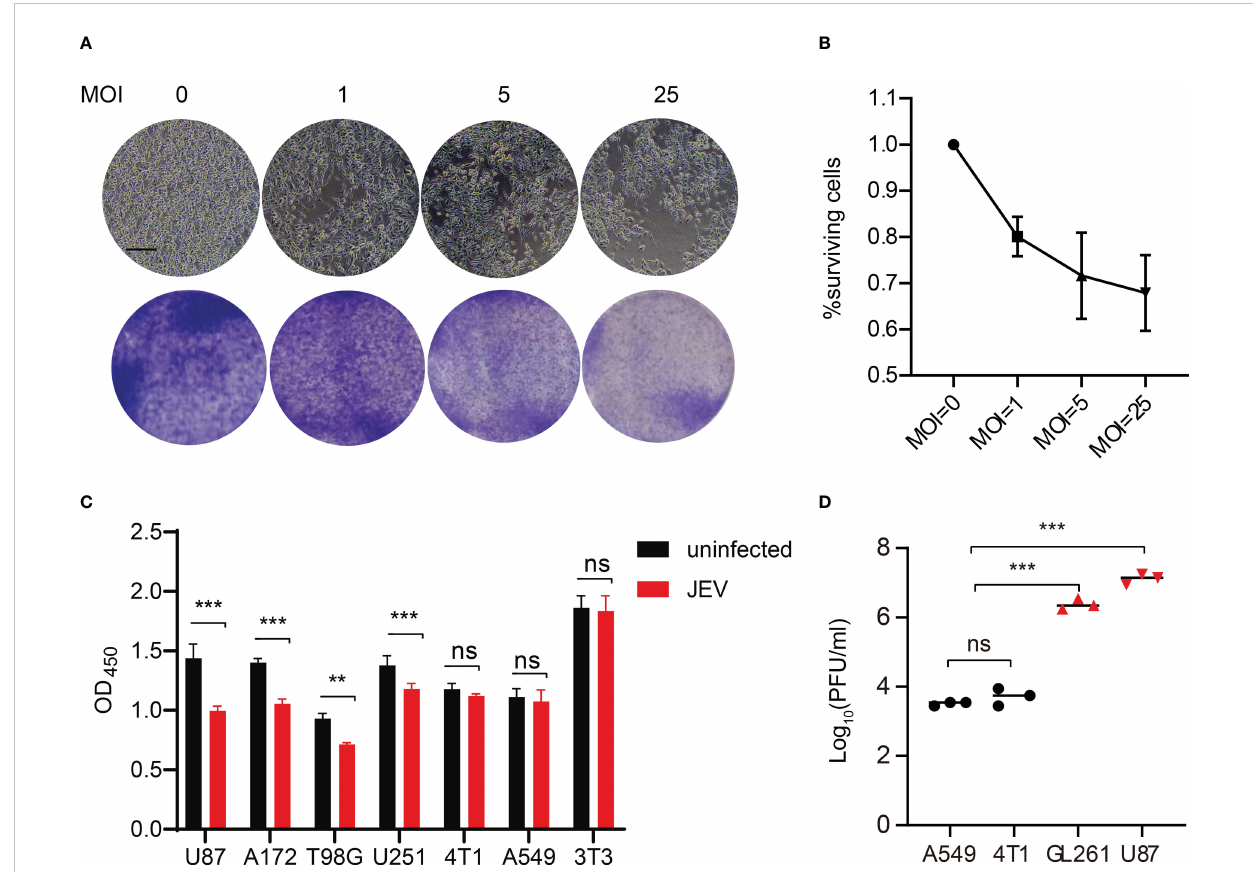
FIGURE 2 JEV-LAV speci fi cally infects and kills GBM cells, but does not harm other non-nervous system tumor cells. (A) Representative images of microscopy and crystal violet staining of GL261 cells infected with JEV-LAV. Scale bars = 200 m m. (B) The inhibitory effect on mouse GBM GL261 cells infected at different MOI. The surviving rate of cells infected at an MOI of 0 was set to 100%. Data were pooled from three independent experiments. (C) Cell viability of human GBM cells (U87, A172, T98G, and U251), human lung cancer cells (A549), mouse breast cancer cells (4T1), and mouse embryonic fi broblast cell (NIH 3T3) after 48 h of JEV-LAV infection (MOI = 25). (D) The replication of JEV-LAV in GBM cells and other non-nervous system tumor cells. **P < 0.01; ***P < 0.001; ns, no